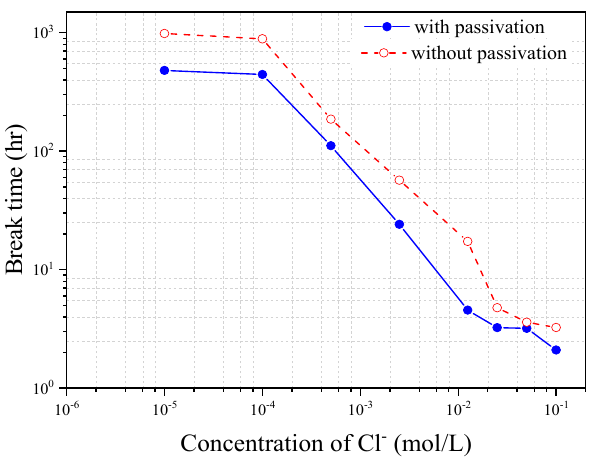
Figure 12. The break time of steel wire with and without passivation treatment under different Cl − concentration solutions (pH = 7, F = 30 N).